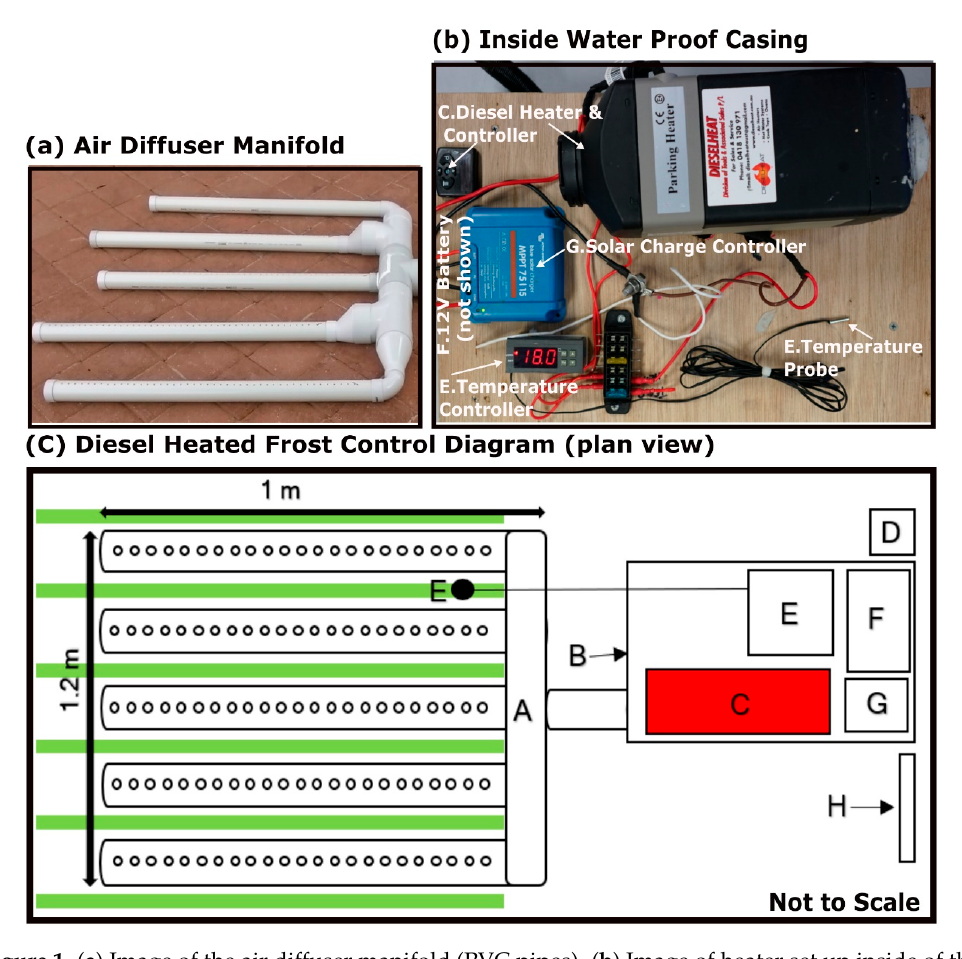
Figure 2. Diesel plot heater set up in a plot at the Dale frost nursery.